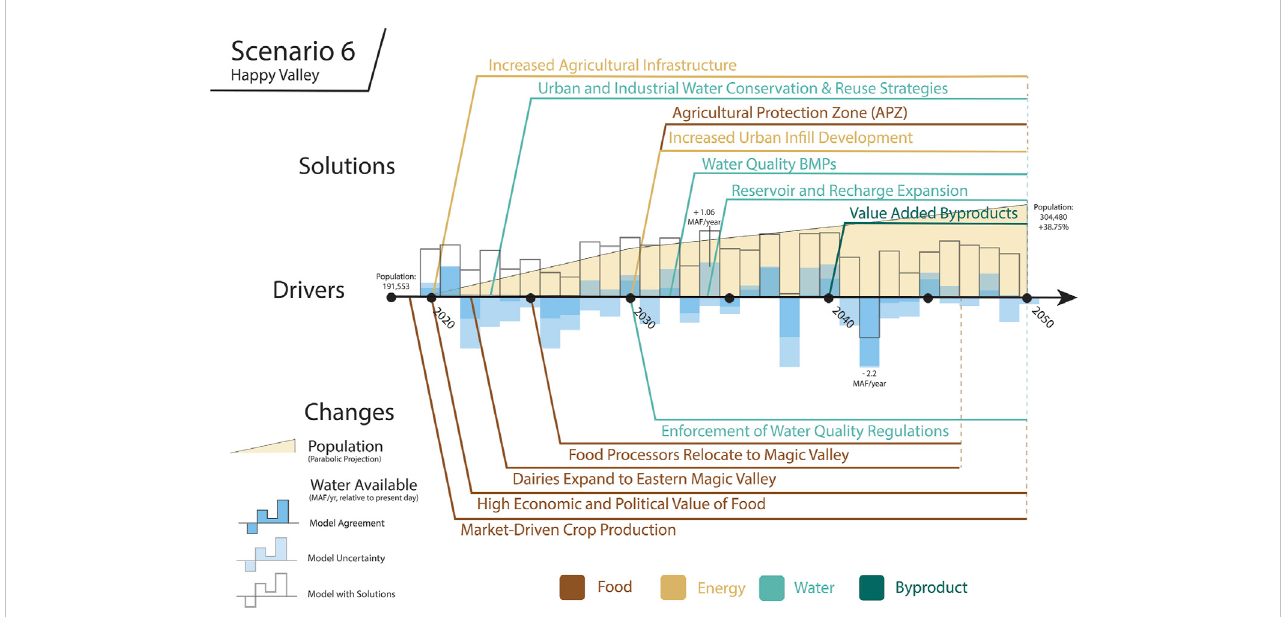
FIGURE 3 Graphic representation of changes in available water and population, likely solutions and timing of solutions for Megadrought scenario. Drivers include population change (in beige) and changes in average water availability (blue histograms). “ Model agreement ” refers to the average of multiple climate model runs, “ model uncertainty ” indicates the variability between those model runs, and “ model with solutions ” indicates the water available once the identi fi ed solutions are implemented (see Cronan et al., 2022b for more information).